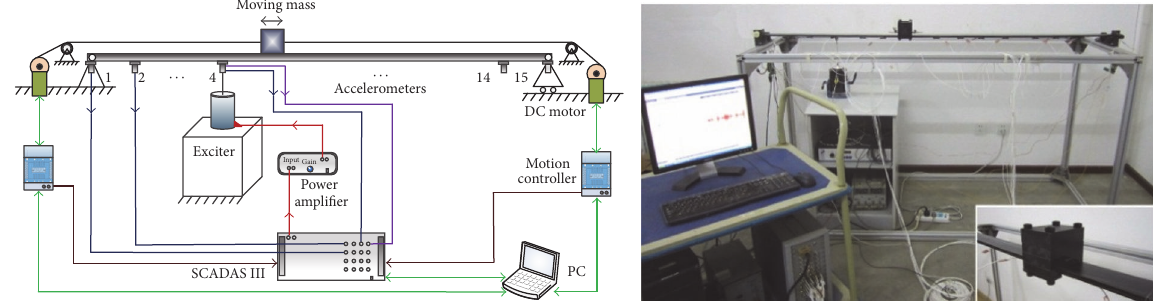
Figure 9: Schematic diagram of the experimental system and photo of its set-up.